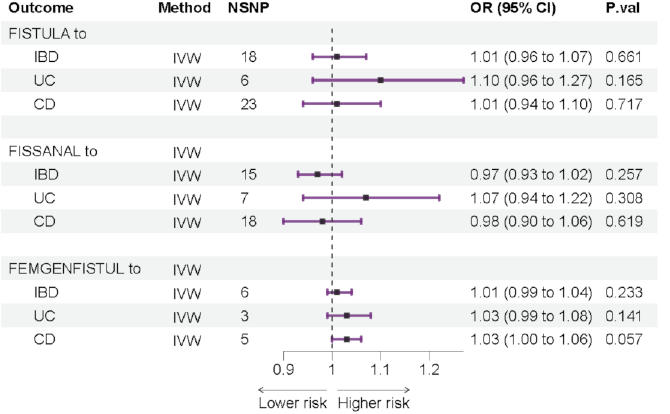
Figure 4. Mendelian randomization (MR) results of IVW. Causal estimation of fistula effects on IBD (IBD: inflammatory bowel disease; UC: ulcerative colitis; CD: Crohn’s disease; FISTULA: colonic or urogenital fistula; FISSANAL: fissure and fistula of anal and rectal regions; FEMGENFISTUL: fistula involving female genital tract; NSNP: the number of single nucleotide polymorphisms used in MR analysis; OR: odds ratio; CI: confidence